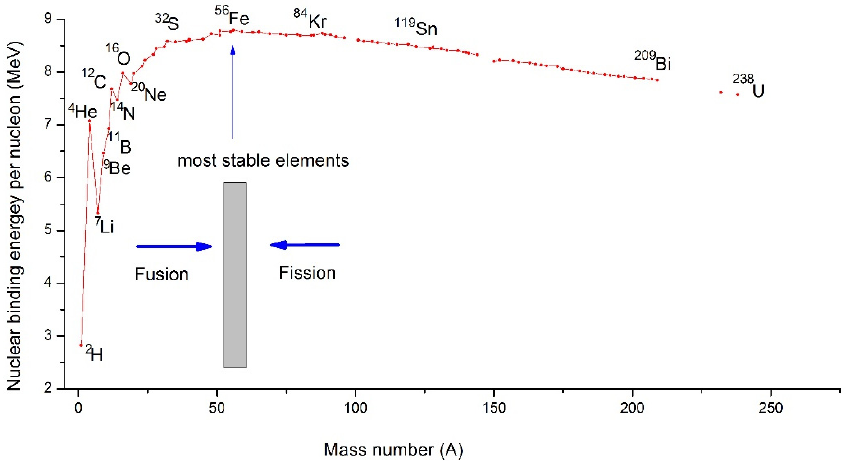
Figure 4. Nuclear binding energy per nucleon for each element in function of their mass number (A).